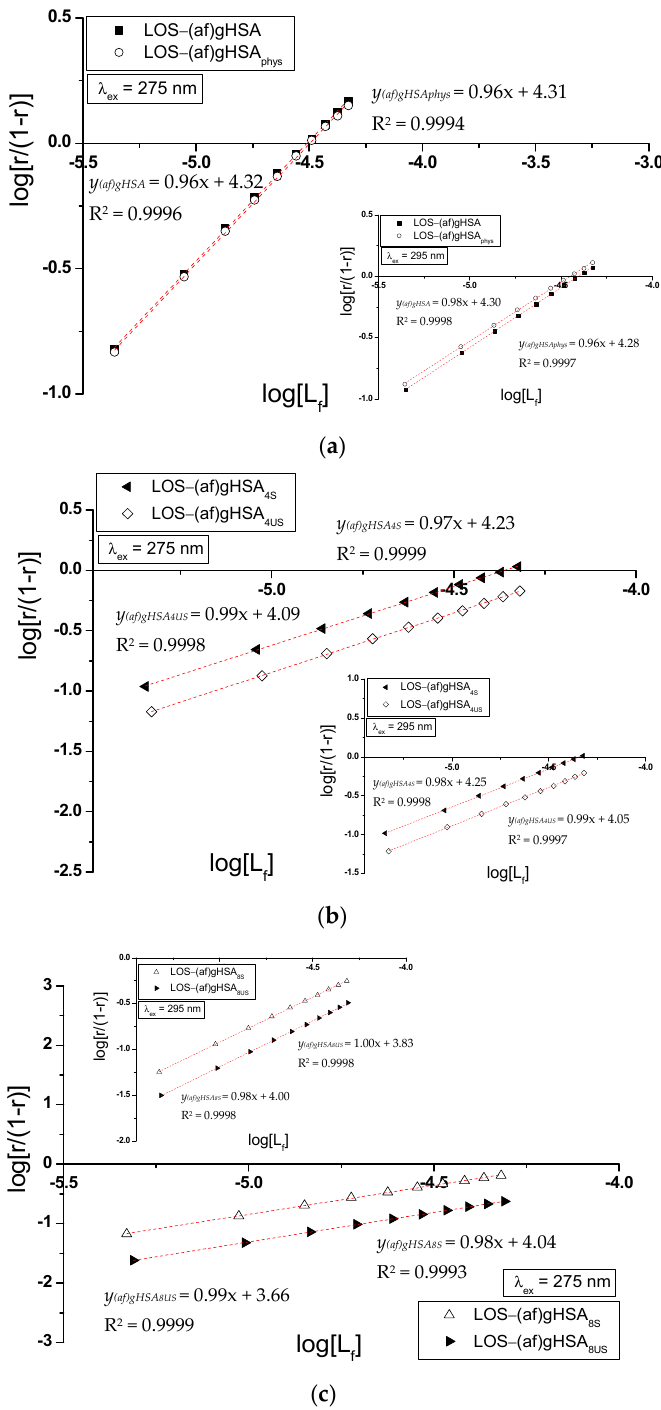
Figure 9. The Hill curves of log[r/(1-r)] vs. log[L f ] for ( a ) LOS-(af)gHSA and LOS-(af)gHSA phys , ( b ) LOS-(af)gHSA 4S and LOS-(af)gHSA 4US , and ( c ) LOS-(af)gHSA 8S and LOS-(af)gHSA 8US systems, λ ex = 275 nm (in the main view), λ ex = 295 nm (in the insert); the error bars are smaller than the symbols. Table 3. Association constants K a (mol − 1 ∙ L), mean number of LOS moles bound with one mole of (af)gHSA, (af)gHSA phys , (af)gHSA 4S , (af)gHSA 4US , (af)gHSA 8S , and (af)gHSA 8US ( n ), the Hill coeffi- cient (n H ) in The LOS–albumin systems; λ ex = 275 nm, λ ex = 295 nm. Scatchard Method